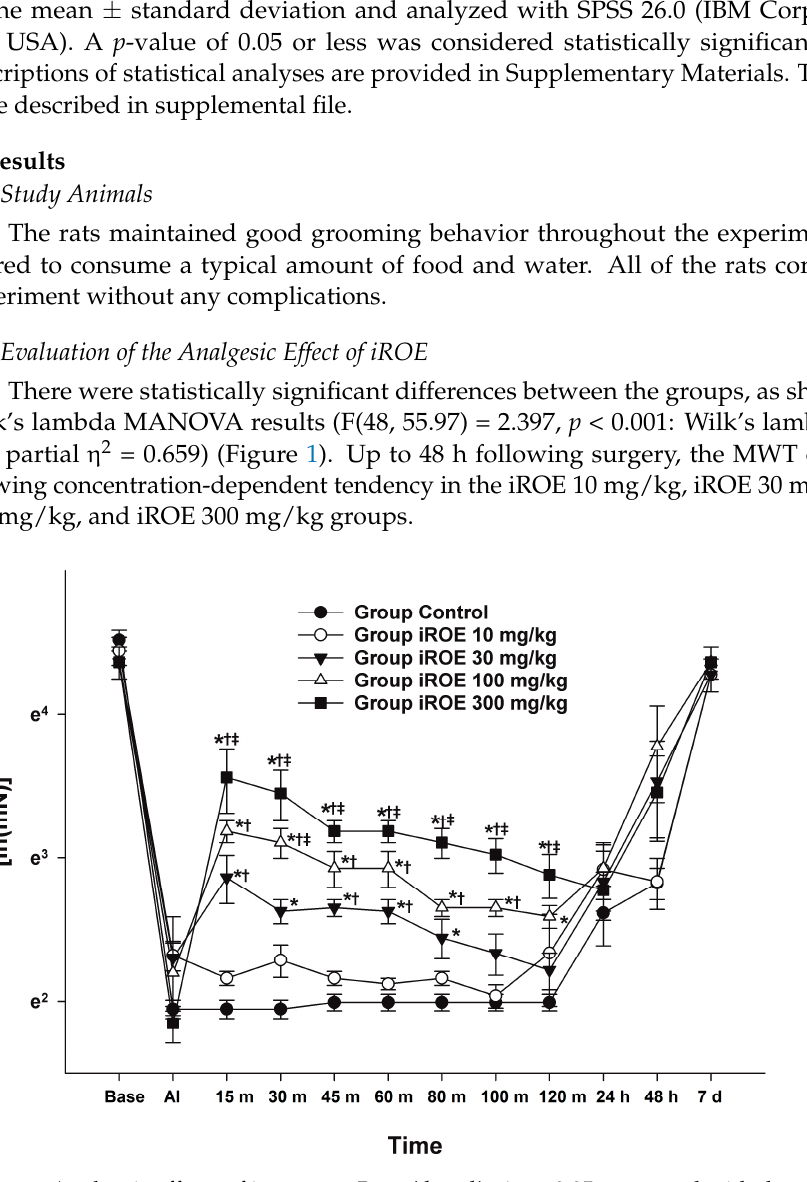
Figure 1. Analgesic effects of immature R. occidentalis . * p < 0.05 compared with the control group, † p < 0.05 compared with iROE 10 mg/kg group, and ‡ p < 0.05 compared with iROE 30 mg/kg group. iROE, immature Rubus occidentalis extract; AI, after incision.